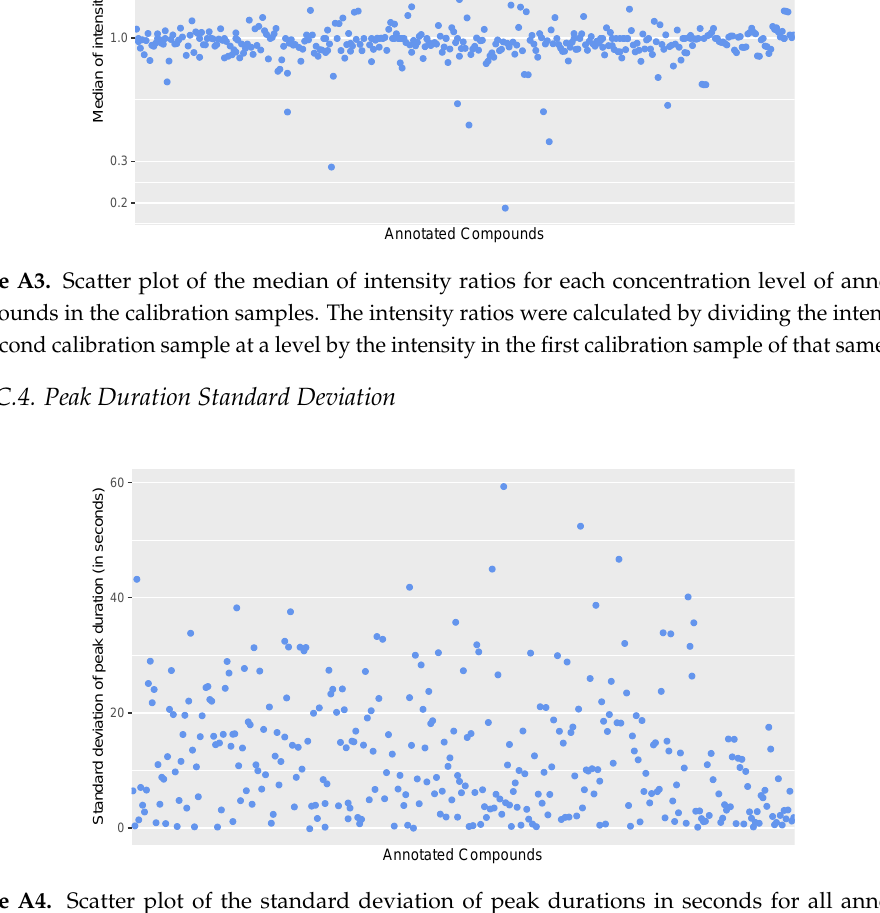
Figure A4. Scatter plot of the standard deviation of peak durations in seconds for all annotated compounds in the calibration